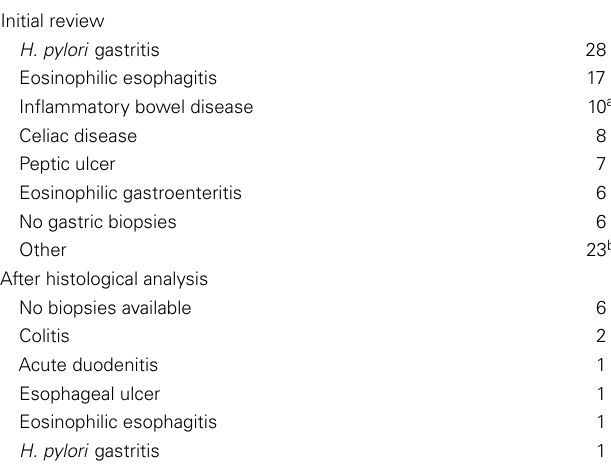
Table 1 | Patients excluded from the analysis .